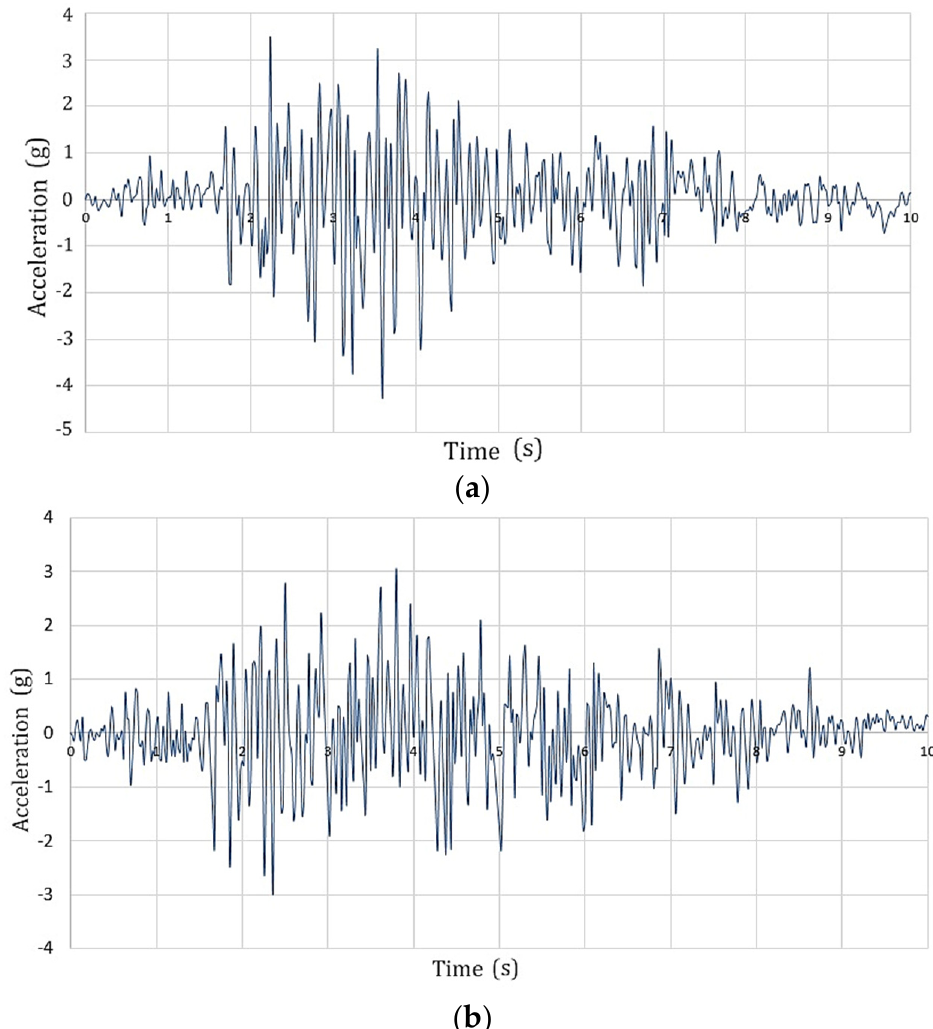
Figure 4. Time history of the vertical/horizontal ground acceleration (Koyna, 1967). ( a ) Horizontal ground acceleration; ( b ) vertical ground